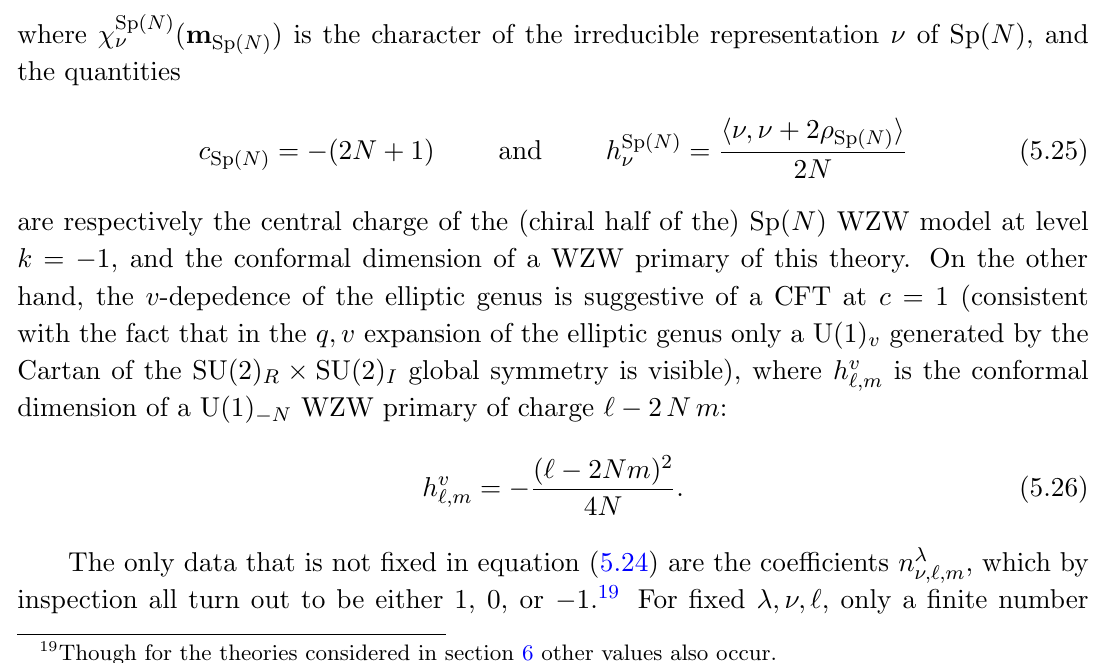
where (cid:31) Sp( N )